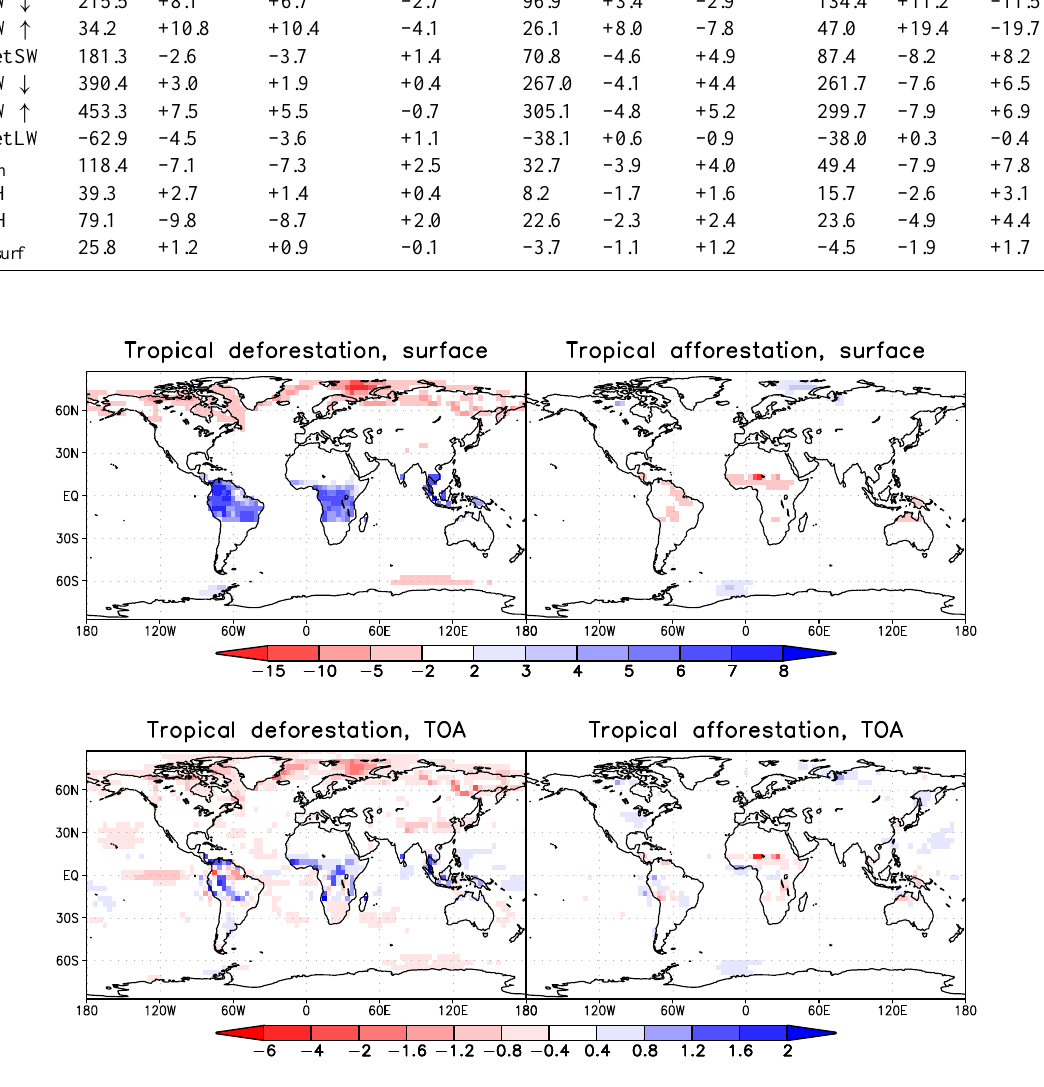
Fig. 7. Anomalies in surface albedo (top) and planetary albedo (bottom) in %, averaged over the final 200years for tropical deforestation (left) and tropical afforestation